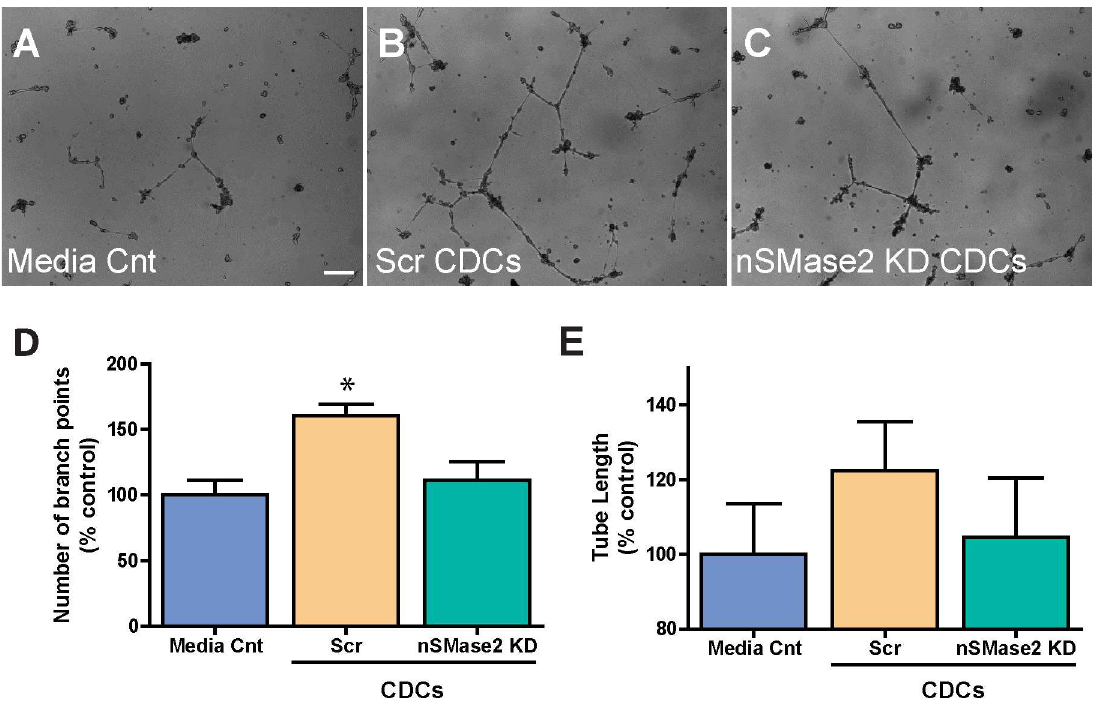
Fig 7. hCDC exosomes stimulate angiogenesis in a HUVEC angiogenesis assay. HUVECs cocultured with Scr CDCs for 24 hours show an increasednumber of branch points and a trend towards increasedtube length as comparedwith HUVECs coculturedwith nSMase2 KD CDCs in a 4 hour matrigel in vitro tube assay (n = 3). Scale bar 200 μ m. * p < 0.001 using one-way AVOVA (Tukey’s post hoc test). Data are presented as mean ±